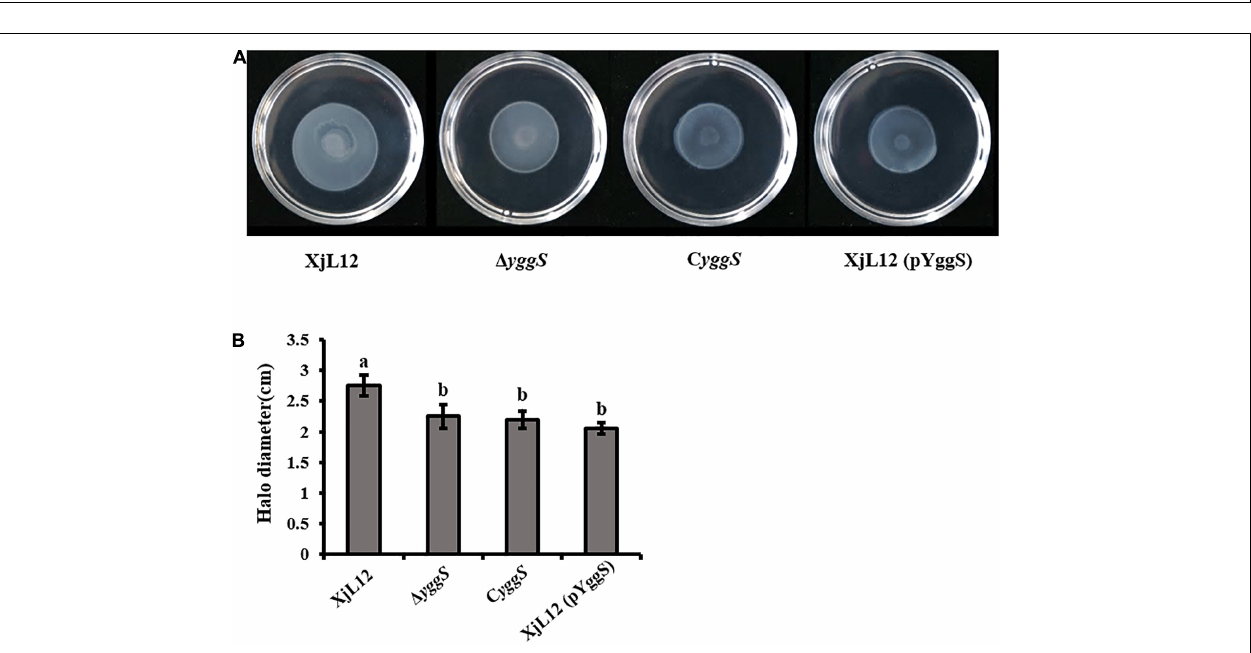
FIGURE 6 | Effect of yggS on Acidovorax citrulli motility. (A) Swimming motility of A. citrulli strains. Bacterial suspensions diluted to 3 × 10 8 CFU/mL with sterilized water were deposited 5 µ L of suspensions in the center of the 0.3% agar plate. The swimming colonies were photographed after 48 h. (B) The swimming colonies diameter of A. citrulli strains were measured after 48 h. The vertical bars in the histogram represent standard errors of the mean for three experiments. Each experiment was repeated three times. XjL12: wild-type strain, (cid:49) yggS : yggS deletion mutant; C yggS : complemented strain of (cid:49) yggS . XjL12 (pYggS): yggS -overexpressed strain. Letters above the bars represent significant differences as determined by the LSD test ( P < 0.05).